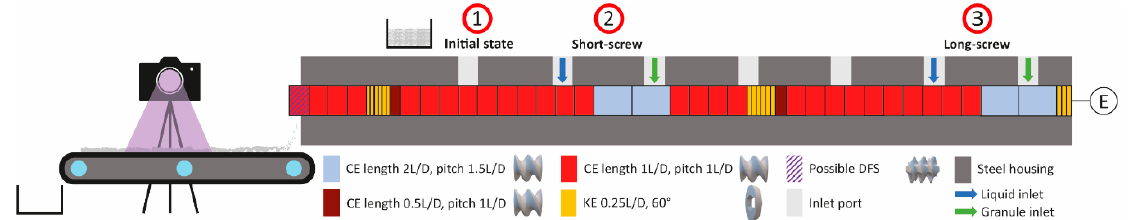
Figure 1. Schematic representation of the experimental setup with (from right to left) engine, twin-screw granulation (TSG) screw, belt conveyor, camera for residence time distribution (RTD) measurements, and sample container. Red circles indicate the data sampling points. DFS, distributive feed screw; CE, conveying element; KE, kneading element.